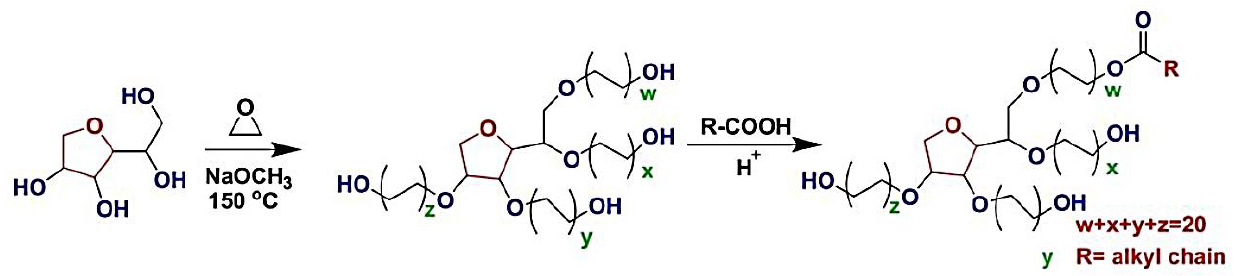
Figure 2. PS synthesis of Sorbitan, adapted from [76] , MDPI, 2021.